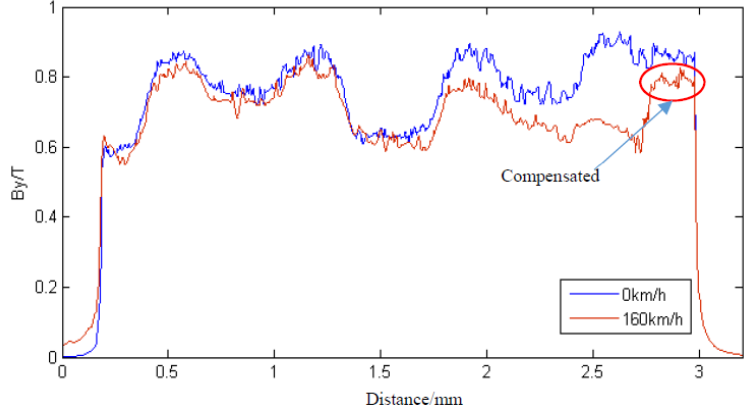
Figure 7. Air-gap flux density of PM hybrid structure.